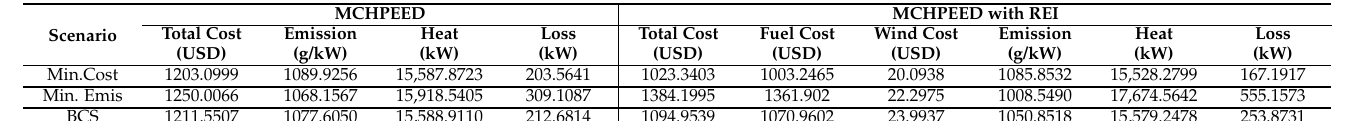
Table 6. Comparative results for MCHPEED and MCHPEED with REI.